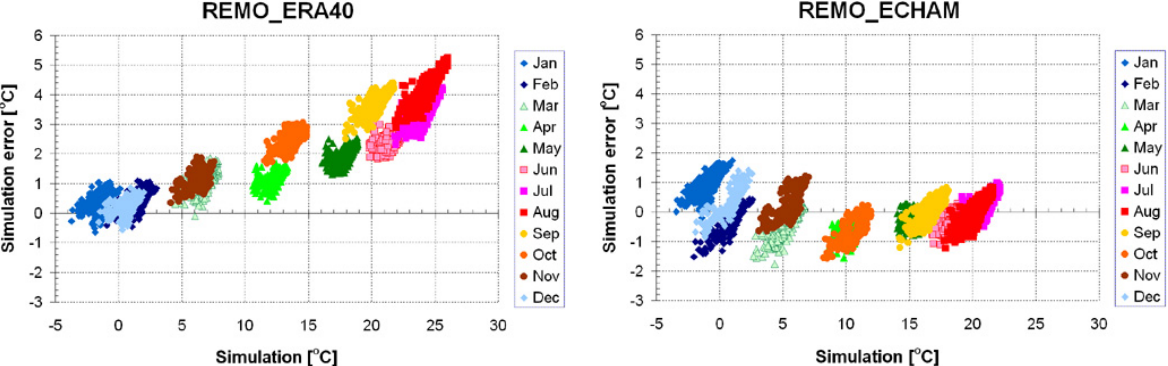
Figure 3. ERA40-driven (left panel) and ECHAM-driven (right panel) REMO simulation errors for monthly mean 2-m temperature [ ◦ C] with respect to the simulated values [ ◦ C] averaged for 1961–1990 in every gridpoint over Hungary. The reference dataset was provided by CRU1.2.